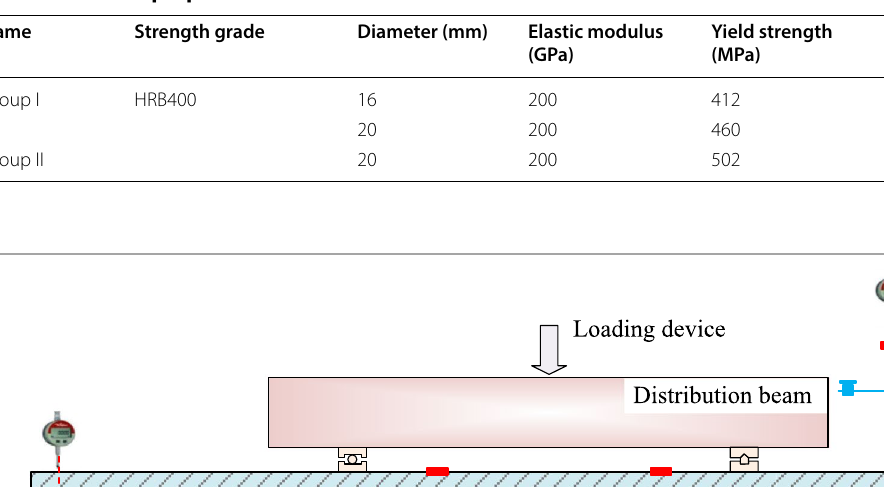
Table 5 Material properties of HRB400 reinforcement.